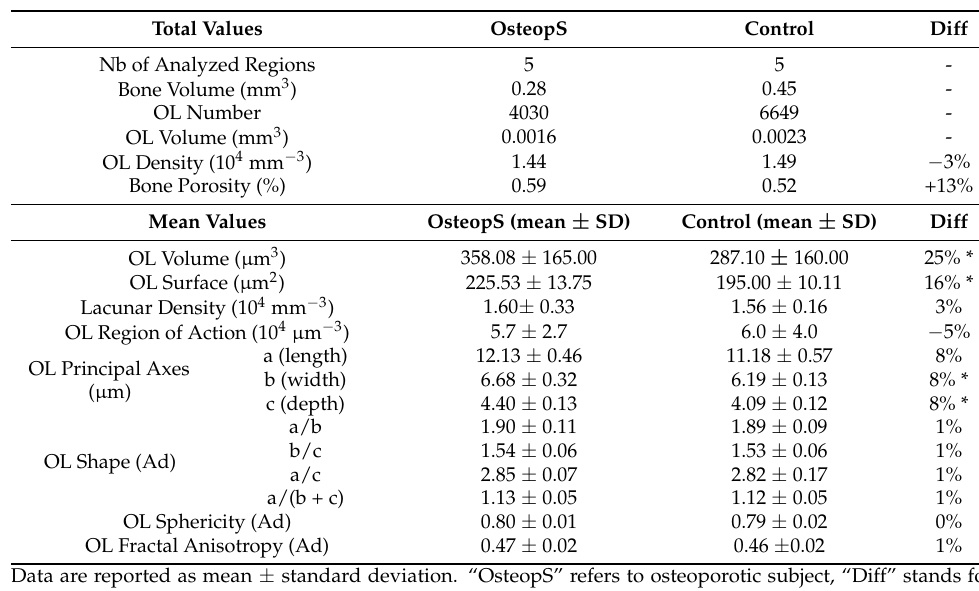
Table 2. Morphometric parameters of osteocytes lacunae (OL).